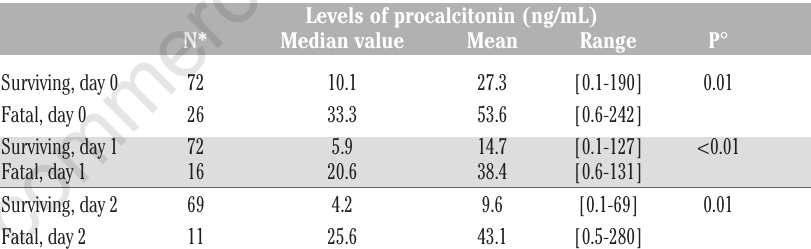
Table 2. Comparison of procalcitonin levels between patients with fatal and non-fatal cerebral malaria.